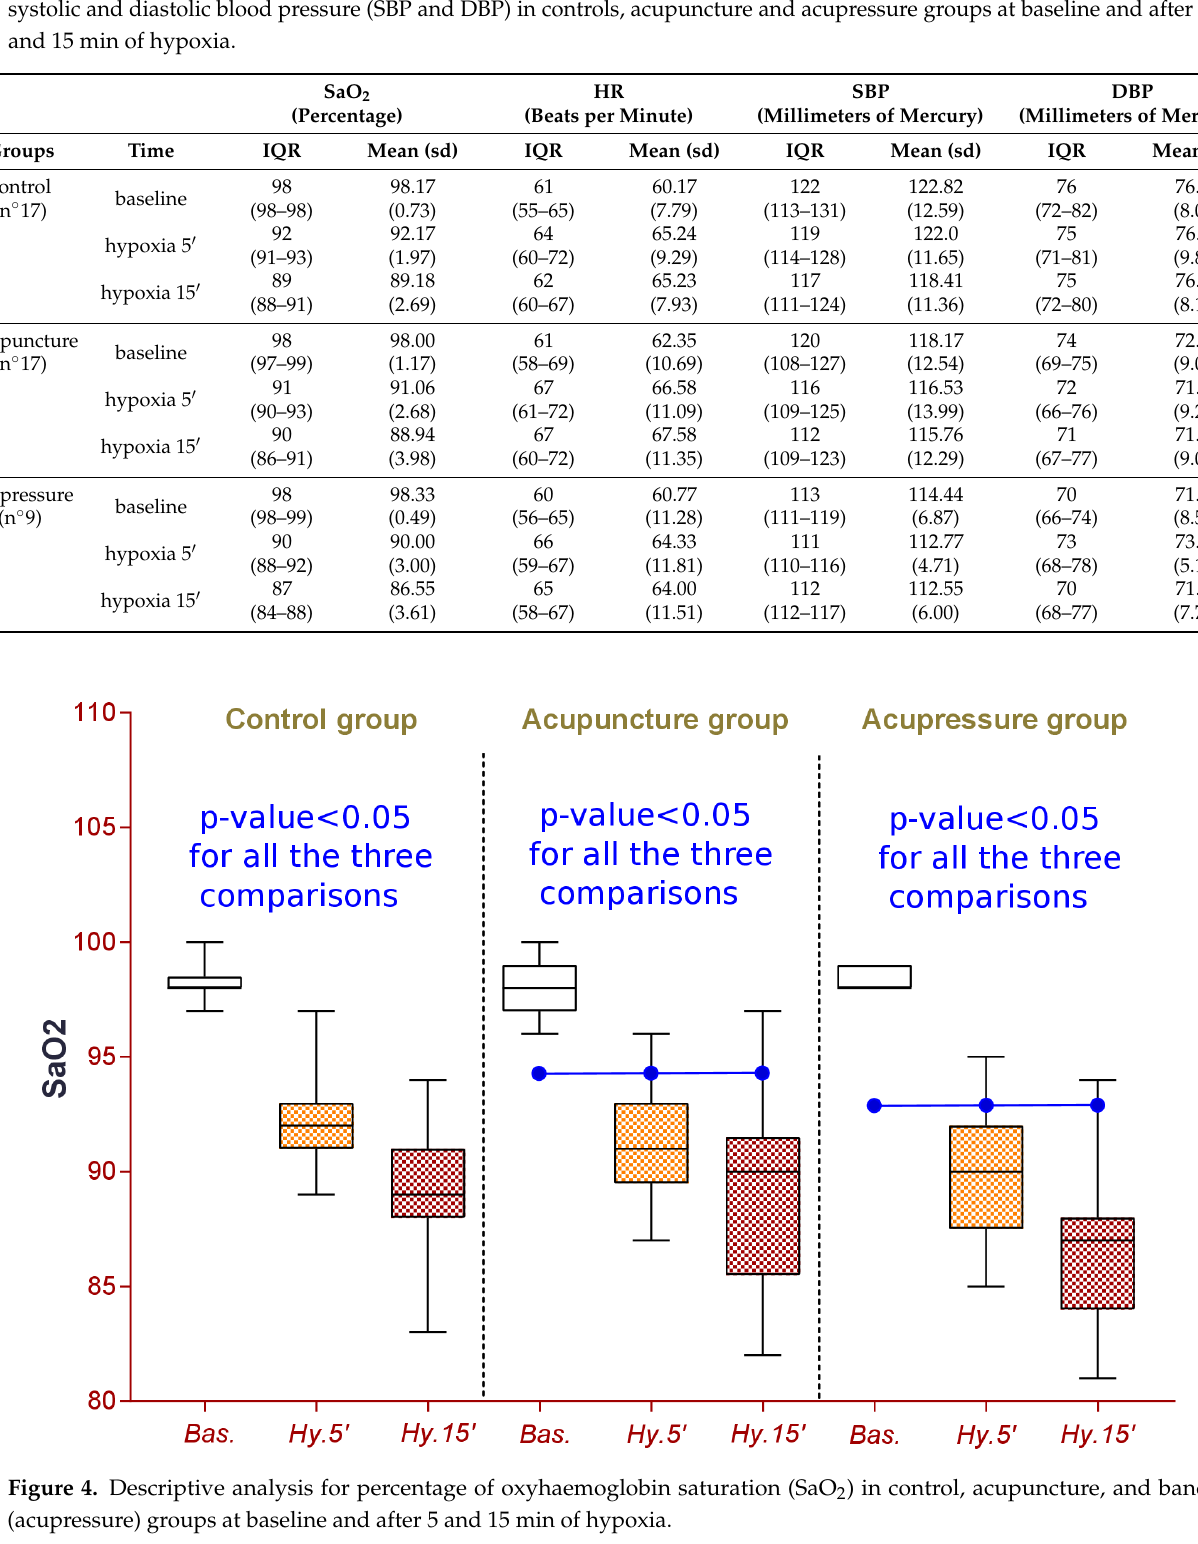
Figure 5. Centimeters per second peak systolic velocity (PSV) in control, acupuncture, and band (acupressure) groups at baseline and after 5 and 15 min of hypoxia.